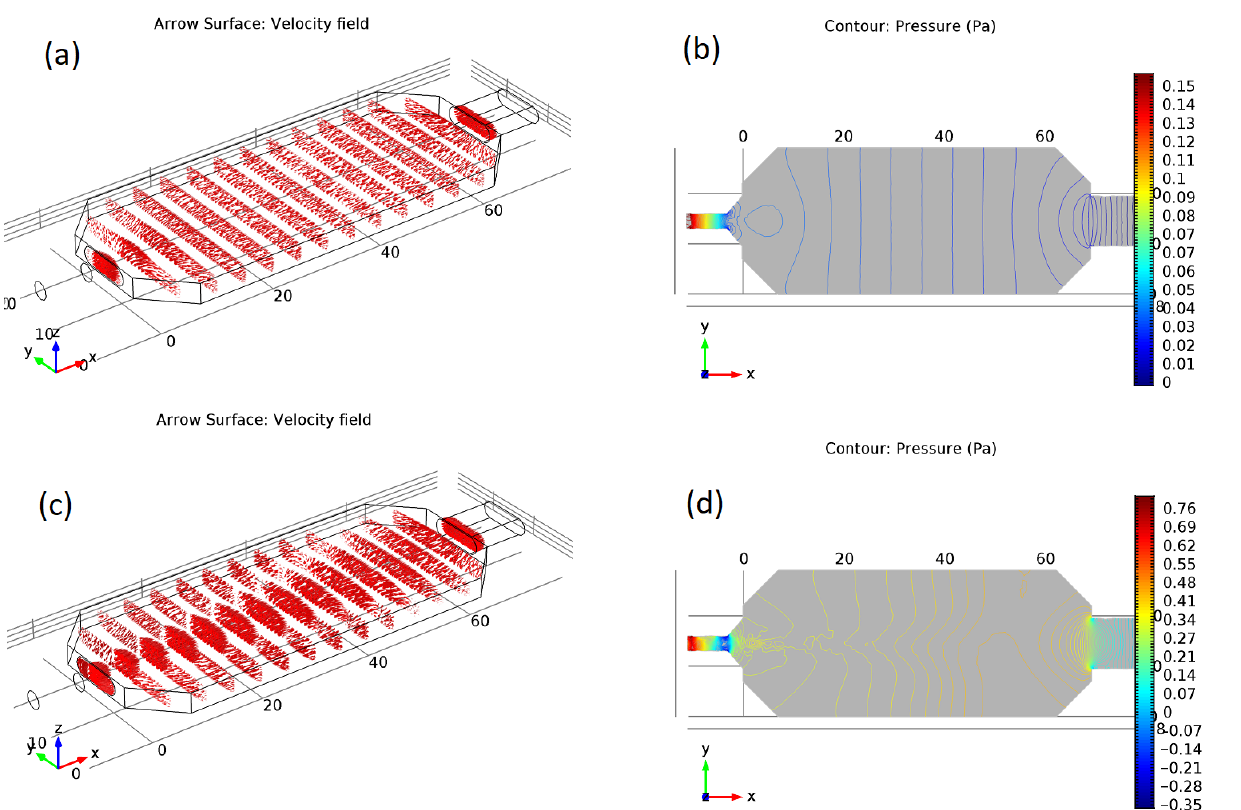
Figure 3. Distribution of air velocity ( a , c ) and pressure ( b , d ) in sensor chamber in closed state, obtained by airflow simulations using COMSOL Multiphysics package. Air input velocity was set to ( a , b ) 0.2 m/s and ( c , d ) 2 m/s; temperature 300